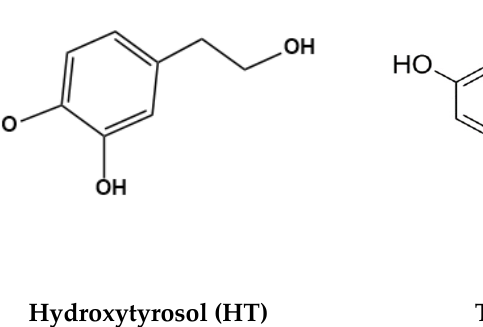
Figure 1. Chemical structures of hydroxytyrosol, tyrosol, and oleuropein.